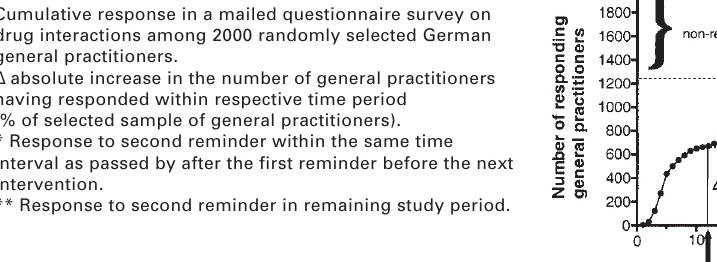
Cumulative response in a mailed questionnaire survey on drug interactions among 2000 randomly selected German general practitioners. ∆ absolute increase in the number of general practitioners having responded within respective time period (% of selected sample of general practitioners). * Response to second reminder within the same time interval as passed by after the first reminder before the next intervention. ** Response to second reminder in remaining study